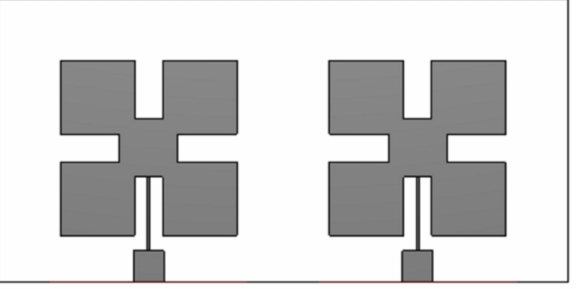
Figure 5. The two-element array of Ant